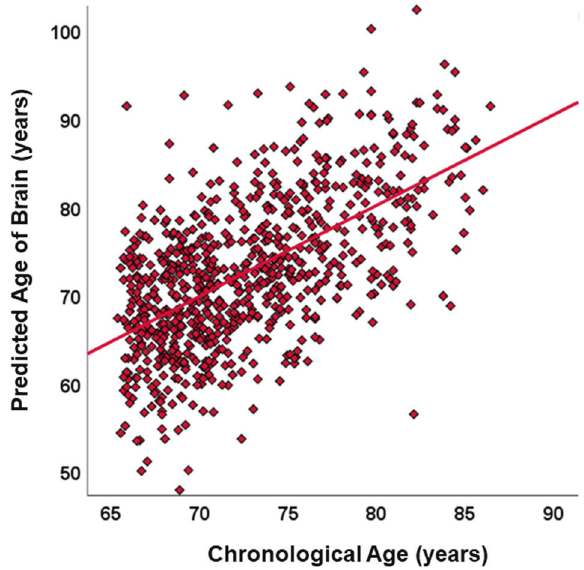
Fig. 2 The scatter plot of chronological age and predicted age of brain. The relationship between chronological age and predicted brain age based on structural